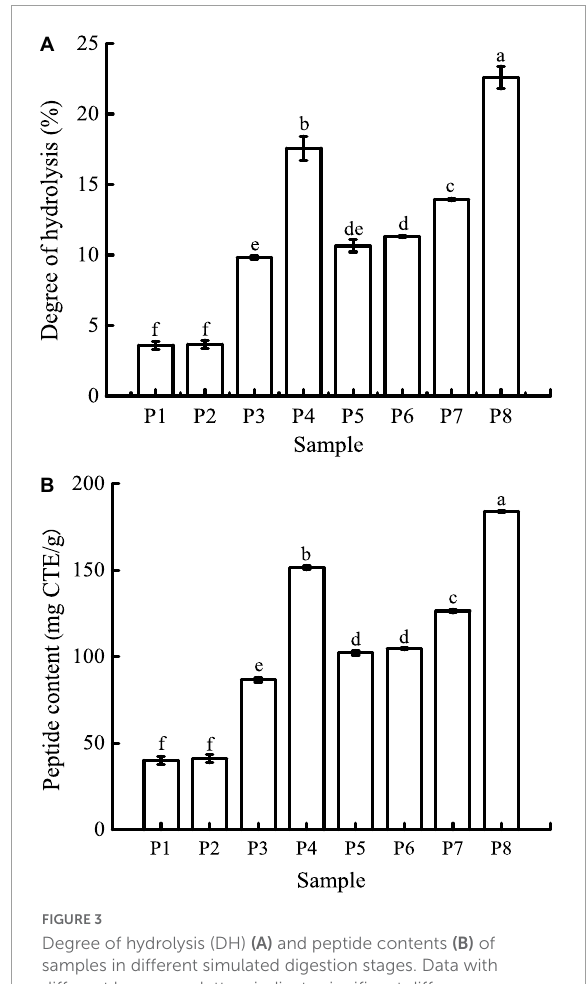
FIGURE3 Degree of hydrolysis (DH) (A) and peptide contents (B) of samples in different simulated digestion stages. Data with different lowercase letters indicate significant differences ( P < 0.05).